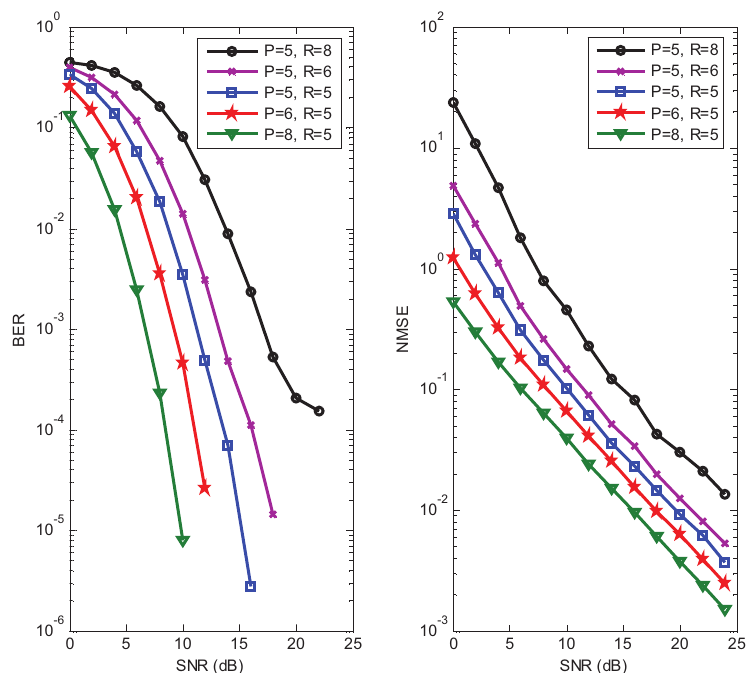
Figure 7. BER and NMSE performance of the proposed receiver for different P and R . (cid:3)